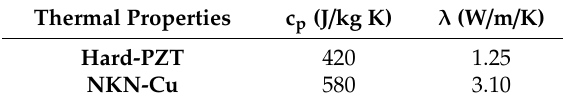
Table 2. Thermal properties of NKN-Cu in comparison with Hard